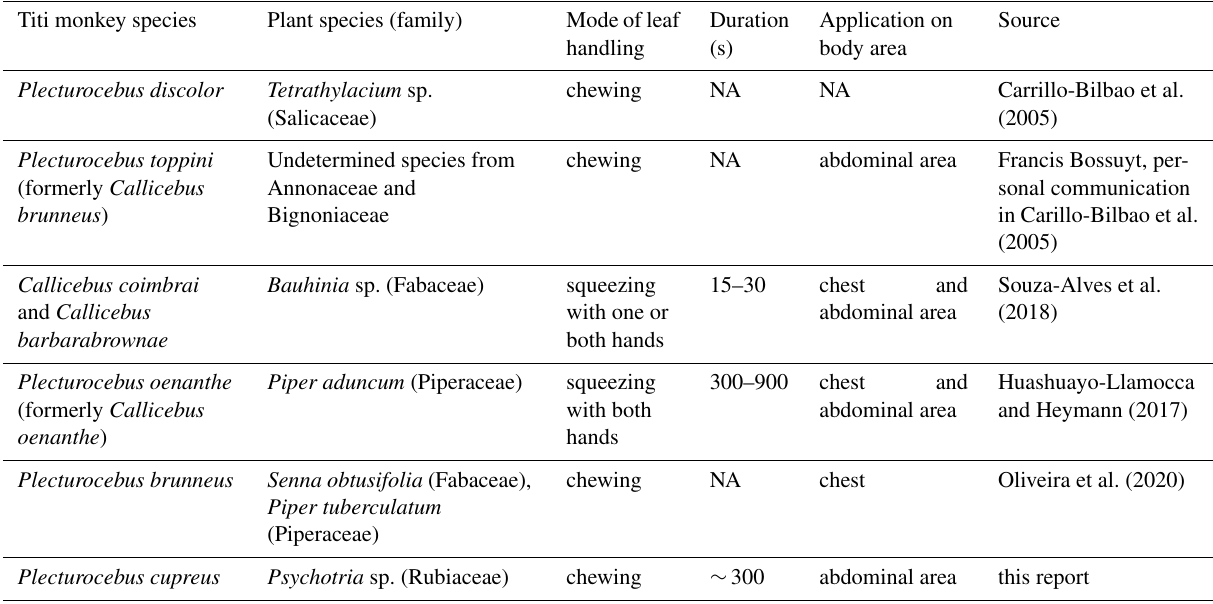
Table 1. A summary of fur rubbing with leaves observed in titi monkeys. NA: information not available. Titi monkey